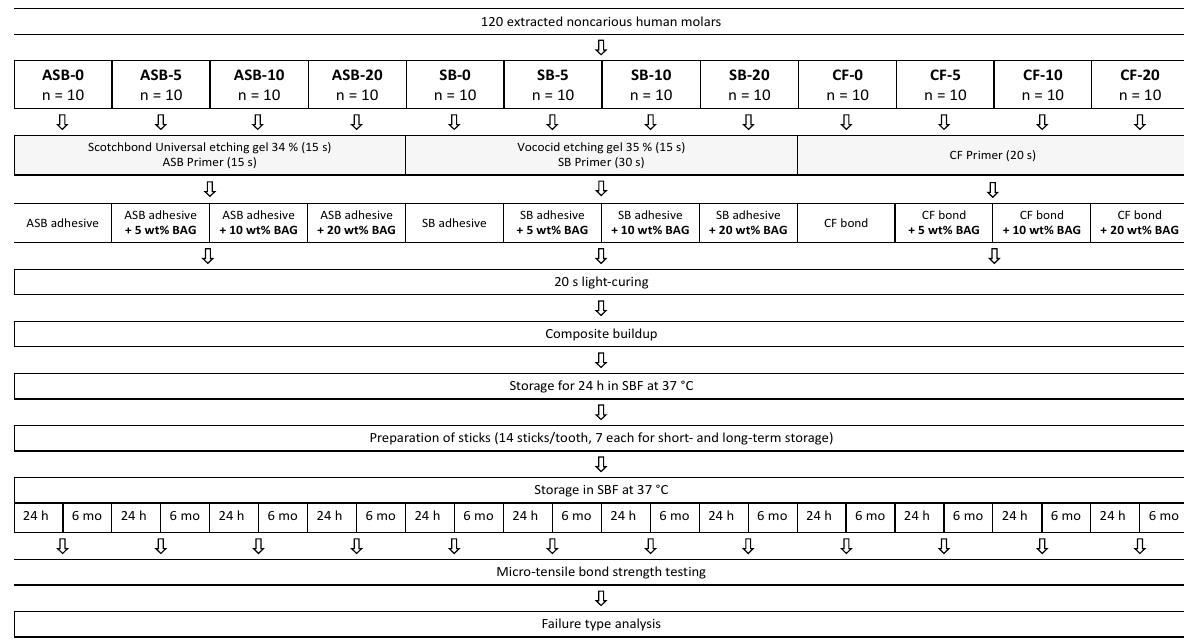
Figure 1. Experimental protocol. ASB: Adper Scotchbond Multi-Purpose; SB: Solobond Plus; CF: Clearfil SE Bond; BAG: bioactive glass 45S5; SBF: simulated body fluid.